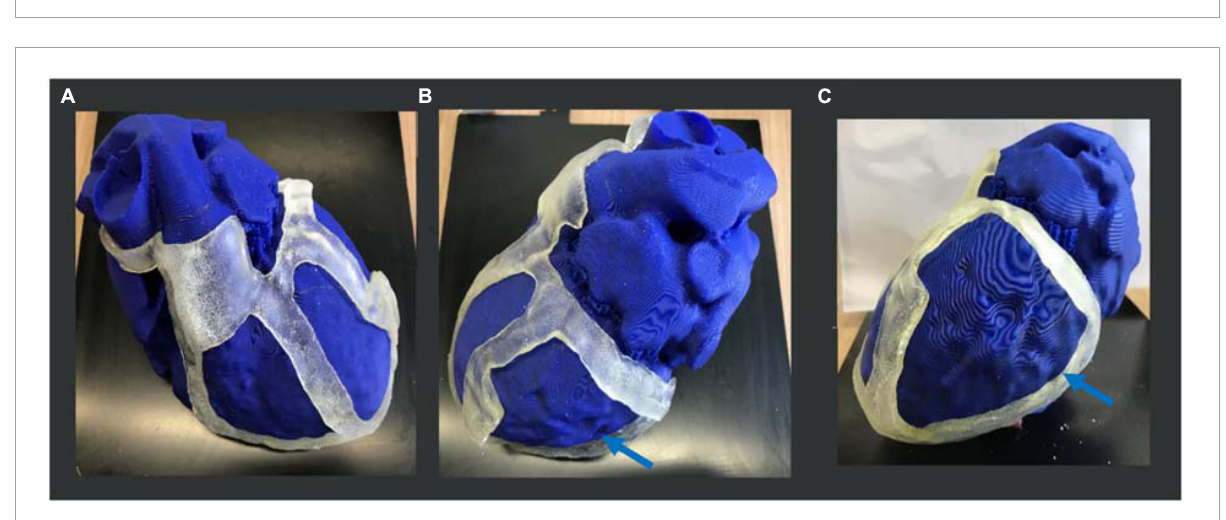
FIGURE9 3D heart phantom fitting test. Three views of the physical 3D surgical guide on the phantom: (A) antero-posterior view; (B) latero-lateral view; (C) postero-anterior view. The 3D surgical guide fitting simulation is performed on the heart phantom, previously printed in PLA by PRUSA 3D printer. The blue arrows show the target (scar) area to be